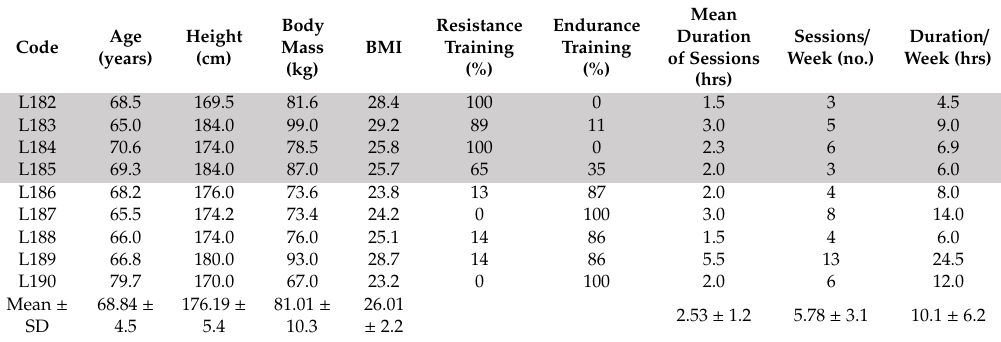
Table 2. Anthropometric and training characteristics of trained subjects.